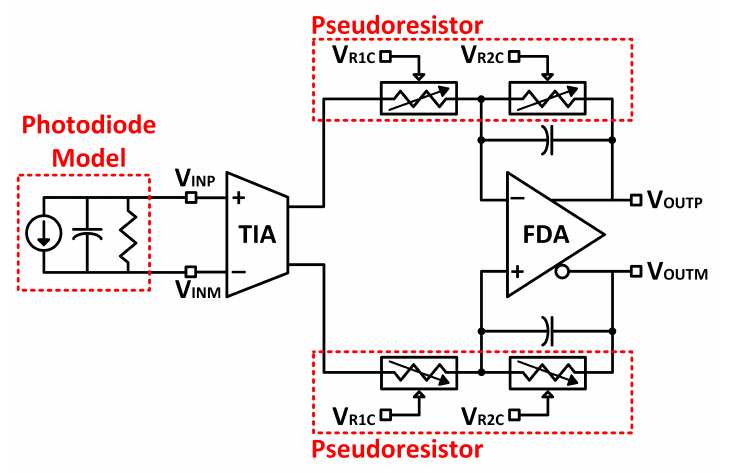
Figure 4. System-level schematic of the AFE